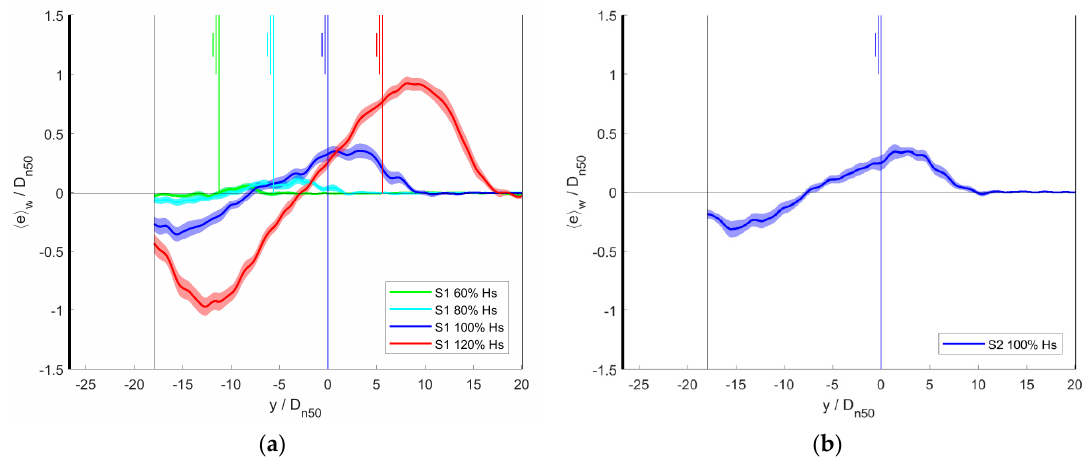
Figure 5. Non-dimensional erosion (positive values) and deposition (negative values) profiles averaged over five tests ( a ) Series S1, for four different water levels; ( b ) Series S2 for the 100% water level), including the 90%-confidence interval.